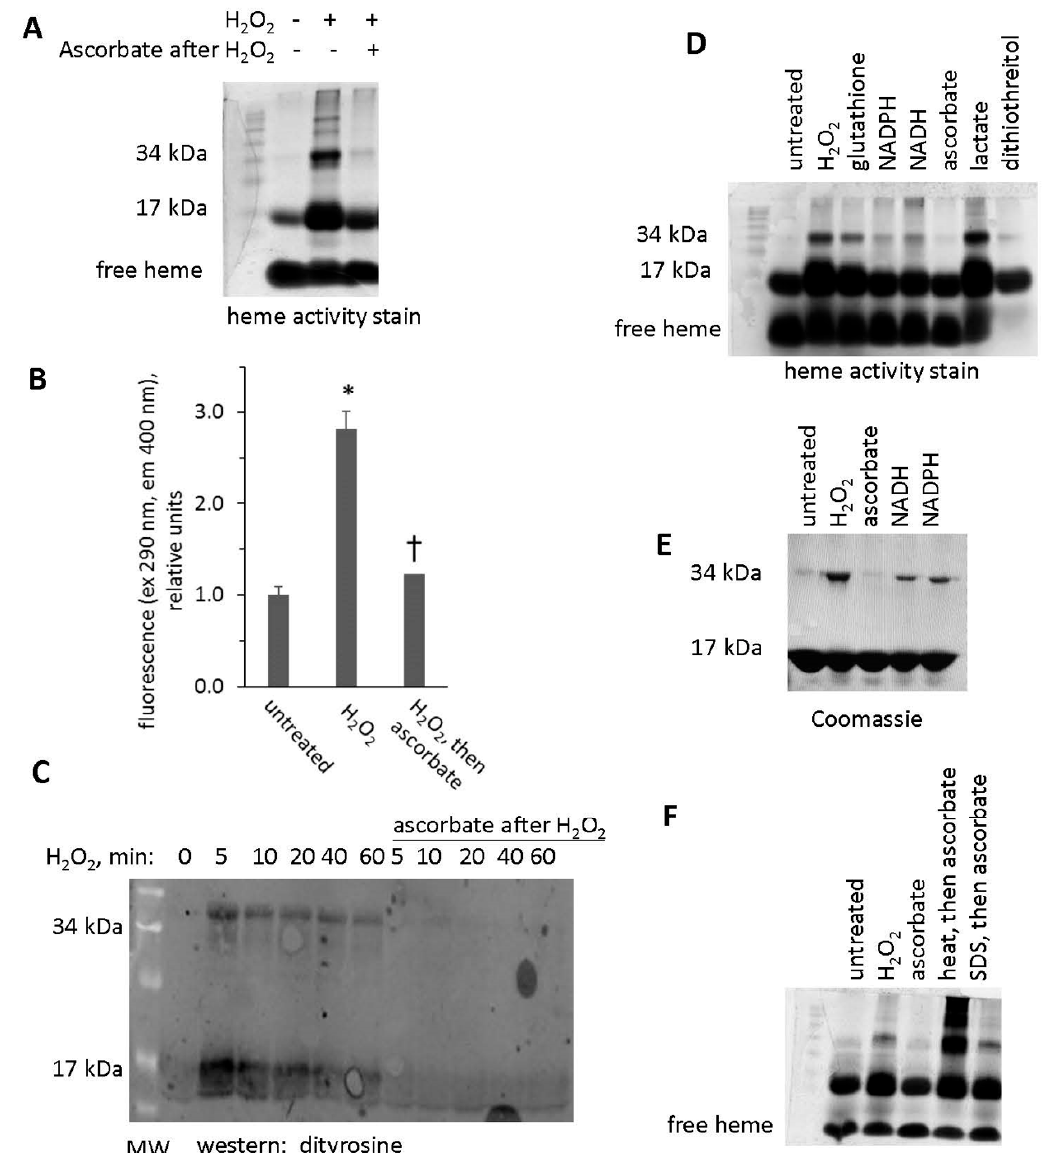
Figure 9. Treatment with ascorbic acid reverses crosslinking of Mb dimers. ( A ) Heme peroxidase activity stain of metMb that was untreated, H 2 O 2 -treated, or H 2 O 2 -treated followed by exposure to ascorbic acid. ( B ) Fluorescence of metMb treated as for panel A was assessed at excitation 290 nm and emission 400 nm, which correspond to the fluorescence characteristics of dityrosine [17], n = 8 / group, * p < 0.001 vs untreated and group treated with peroxide and then ascorbic acid, † p = 0.05 vs untreated. (C) Western blot of ascorbic acid-treated oxidized metMb using an anti-dityrosine antibody. (D) Heme stain of H 2 O 2 -reacted metMb that was then treated with various reducing substrates. (E) Coomassie stain of Mb exposed to H 2 O 2 and then reducing agents. (F) Heme stain of oxidized metMb that was denatured by heating for 10 min at 90 ◦ C or by adding SDS-PAGE sample loading bu ff er prior to the addition of ascorbic